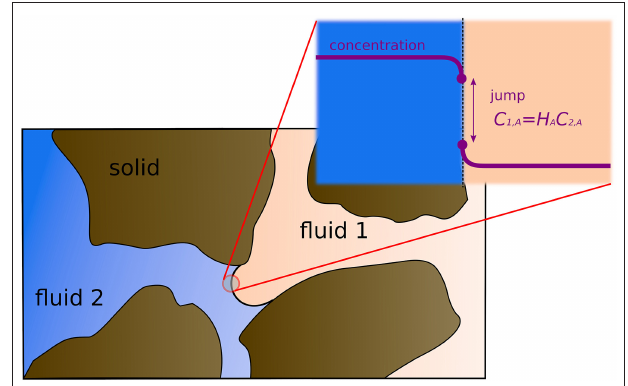
FIGURE 6 | Illustration of multicomponent mass transfer in two-phase flow at the pore-scale. Thermodynamic equilibrium at the fluid/fluid interface obeys a partitioning relationship such as Henry’s